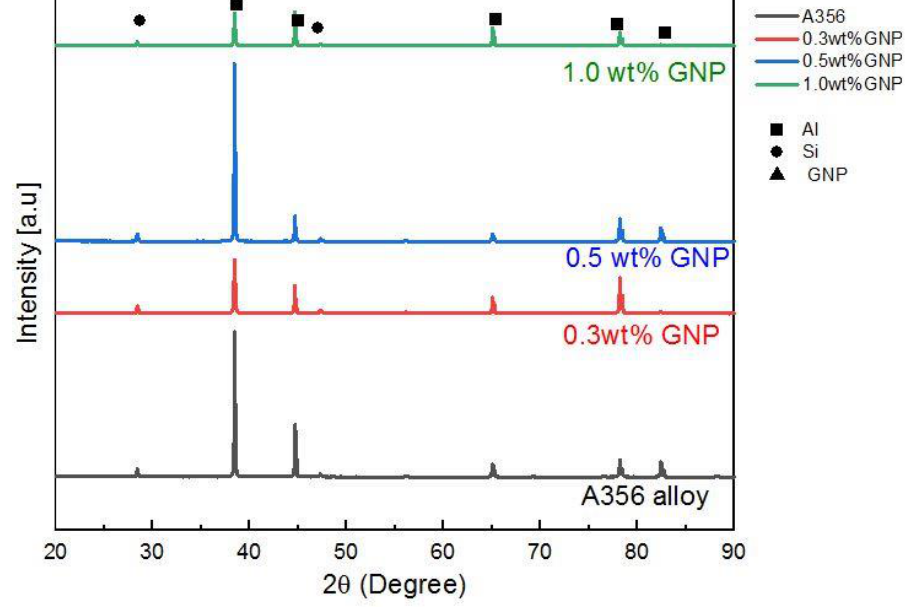
Figure 5. XRD pattern for GNPs/Al composites with variation in GNP content .